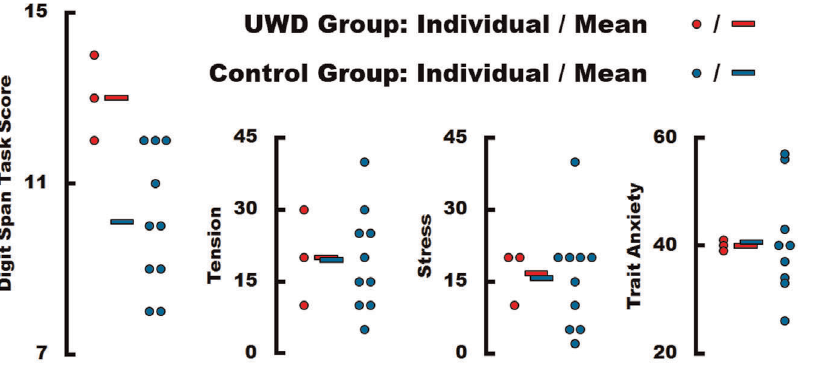
Figure 5. Working Memory scores (for 2010) on the Digit Span task showing superior performance of three UWD subjects with bilateral basolateral amygdala calcification compared to ten normal controls. Subjects were asked to rate on a scale of 1 to 100 how much Stress and Tension they felt during the task. Trait anxiety results for the Spielberger Trait Anxiety Inventory are also shown.